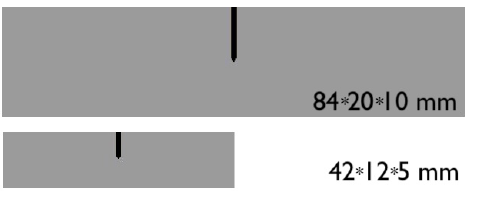
Figure 7. Sketch including pre-notch and dimensions for both the large and the medium-sized samples.